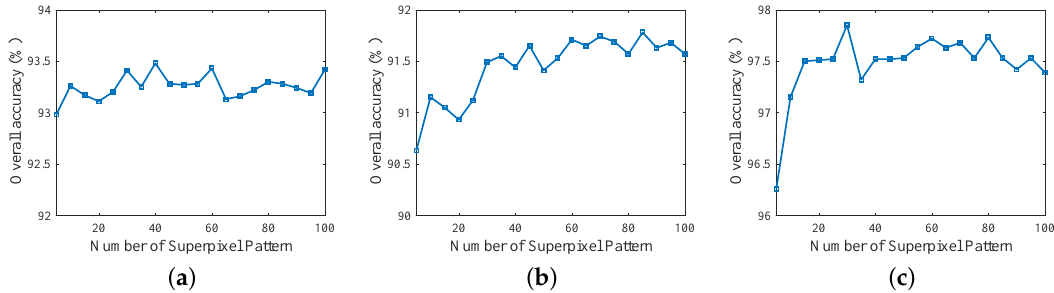
Figure 8. Overall accuracy of the proposed method with different dimensions of superpixel patterns: ( a ) Indian Pines; ( b ) University of Pavia; and ( c ) Salinas